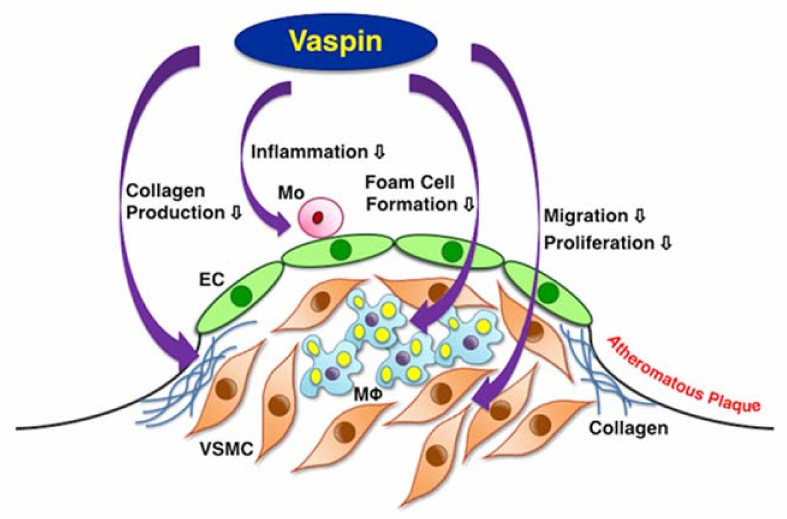
Figure 7. Schema of multiple anti-atherogenic effects of vaspin. EC = endothelial cell, Mo = monocyte, M ϕ = macrophage, VSMC = vascular smooth muscle